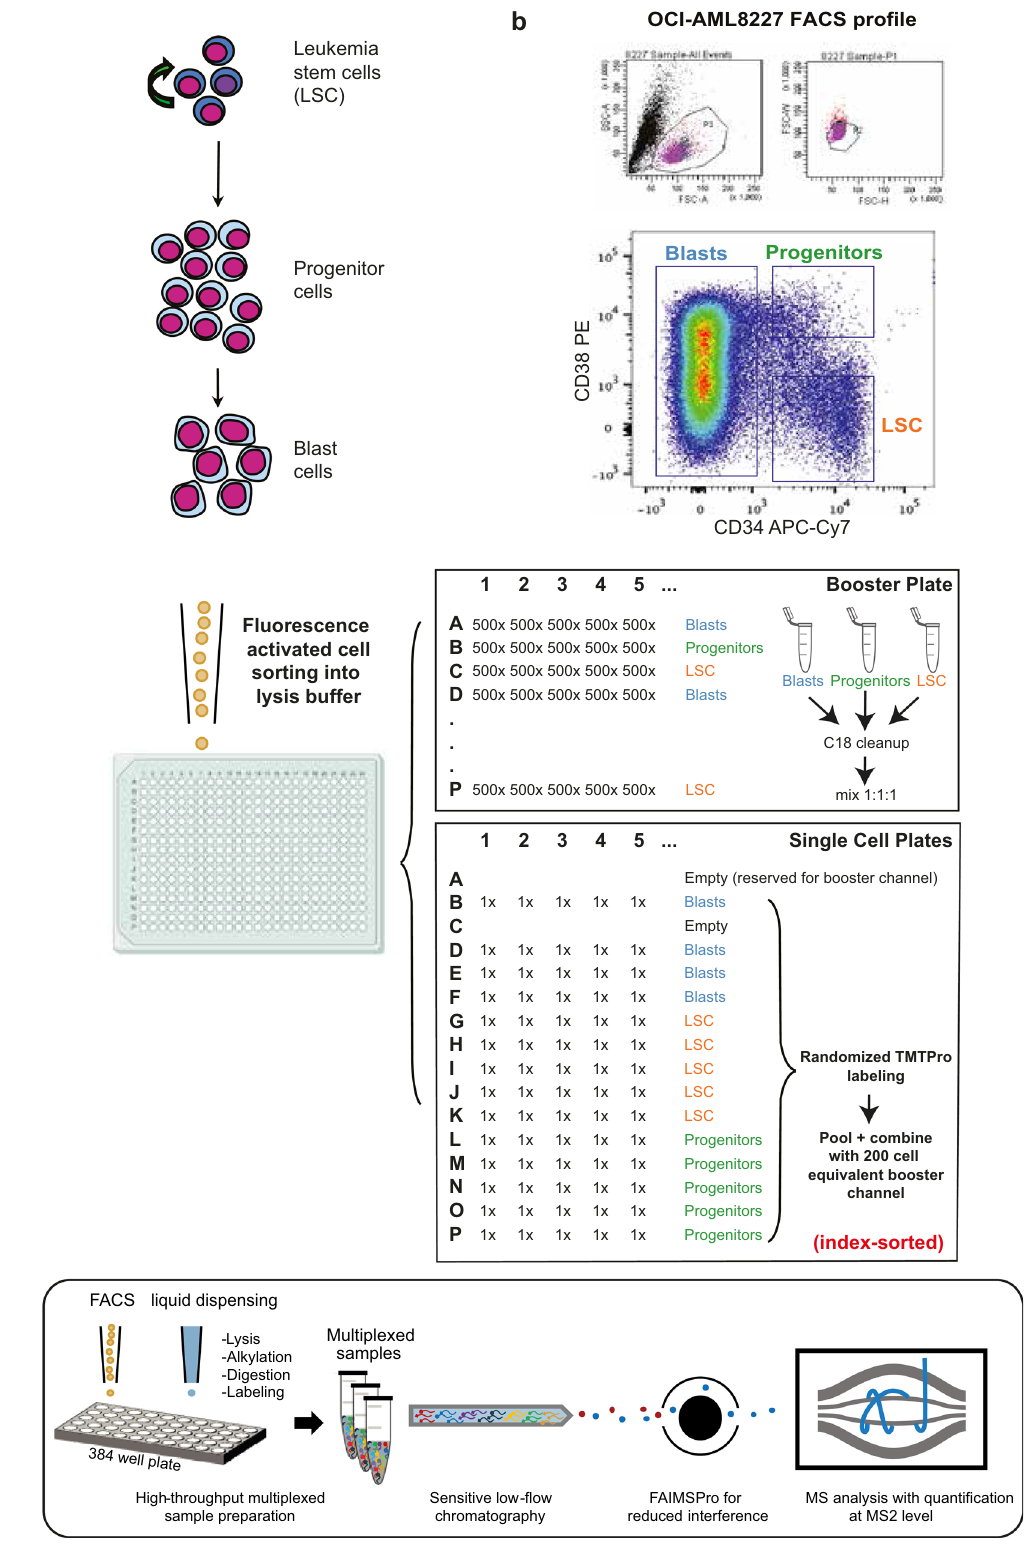
Fig. 1 Experimental overview of our scMS work fl ow. a Overview of the hierarchical nature of an Acute Myeloid Leukemia hierarchy, with leukemic stem cells (LSC) at the apex, differentiating into progenitors, and subsequently, blasts. b FACS plot of the OCI-AML8227 hierarchy according to their CD34/CD38 surface marker expression levels. P1 are cells deemed live, P2 excludes doublets and Blasts, Progenitors and LSC are annotated according to CD34/CD38 expression. c scMS sample creation overview of booster channel samples and single cells; single-cell TMTpro samples were created with four Blast, fi ve LSC and fi ve Progenitor cells in each pool, labeled randomly using fourteen available TMTpro channels before pooling with a 200-cell equivalent of the 126-labeled booster sample. d Conceptual overview of our scMS experimental pipeline; single cells are sorted into 384-well plates containing 1ul of lysis buffer, then digested, TMT labeled and multiplexed. Resulting samples are analyzed with LC – MS via FAIMSPro gas-phase fractionation and Orbitrap